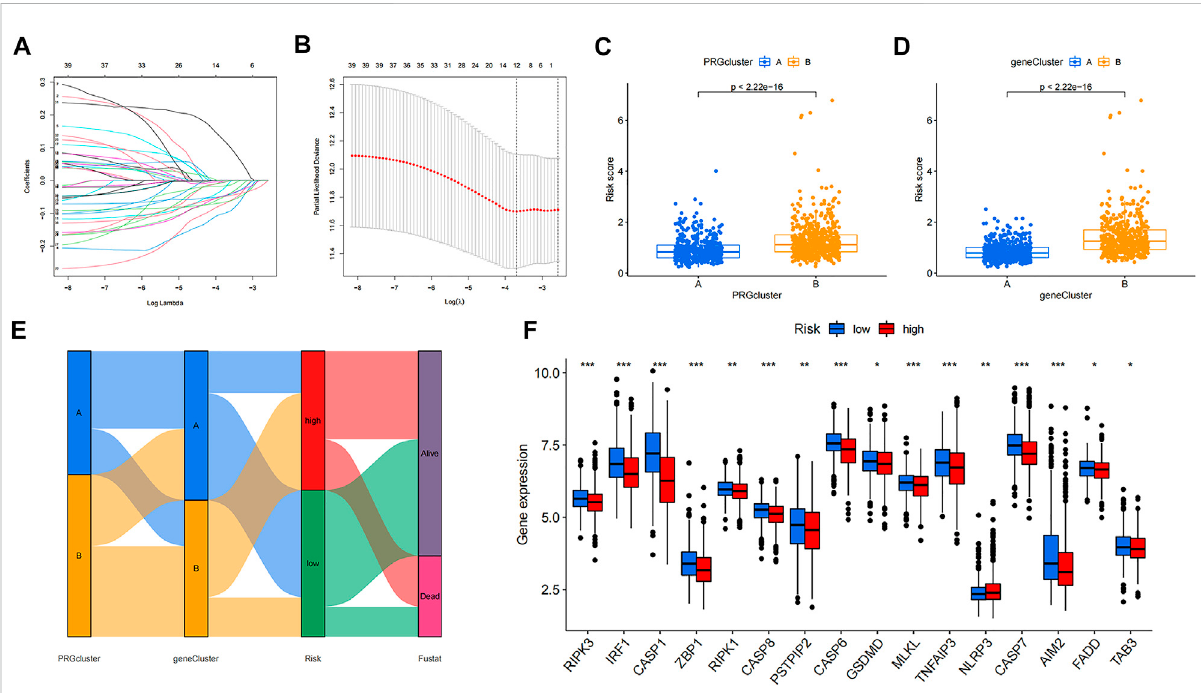
FIGURE 4 Identi fi cation of 7genes for calculating the riskscore and the relationship betweenmolecular classi fi cations, PRGexpression levelsand the risk score. (A – B) The LASSO regression analysis and partial likelihood deviance on the prognostic genes. (C – D) Association between risk score and molecular classi fi cations. (E) Sankey plot showed the correlation between molecular classi fi cations, risk groups and survival status in colon cancer patients. (F) Expression levels of PRGs in two risk groups. * p < 0.05; ** p < 0.01; and *** p <